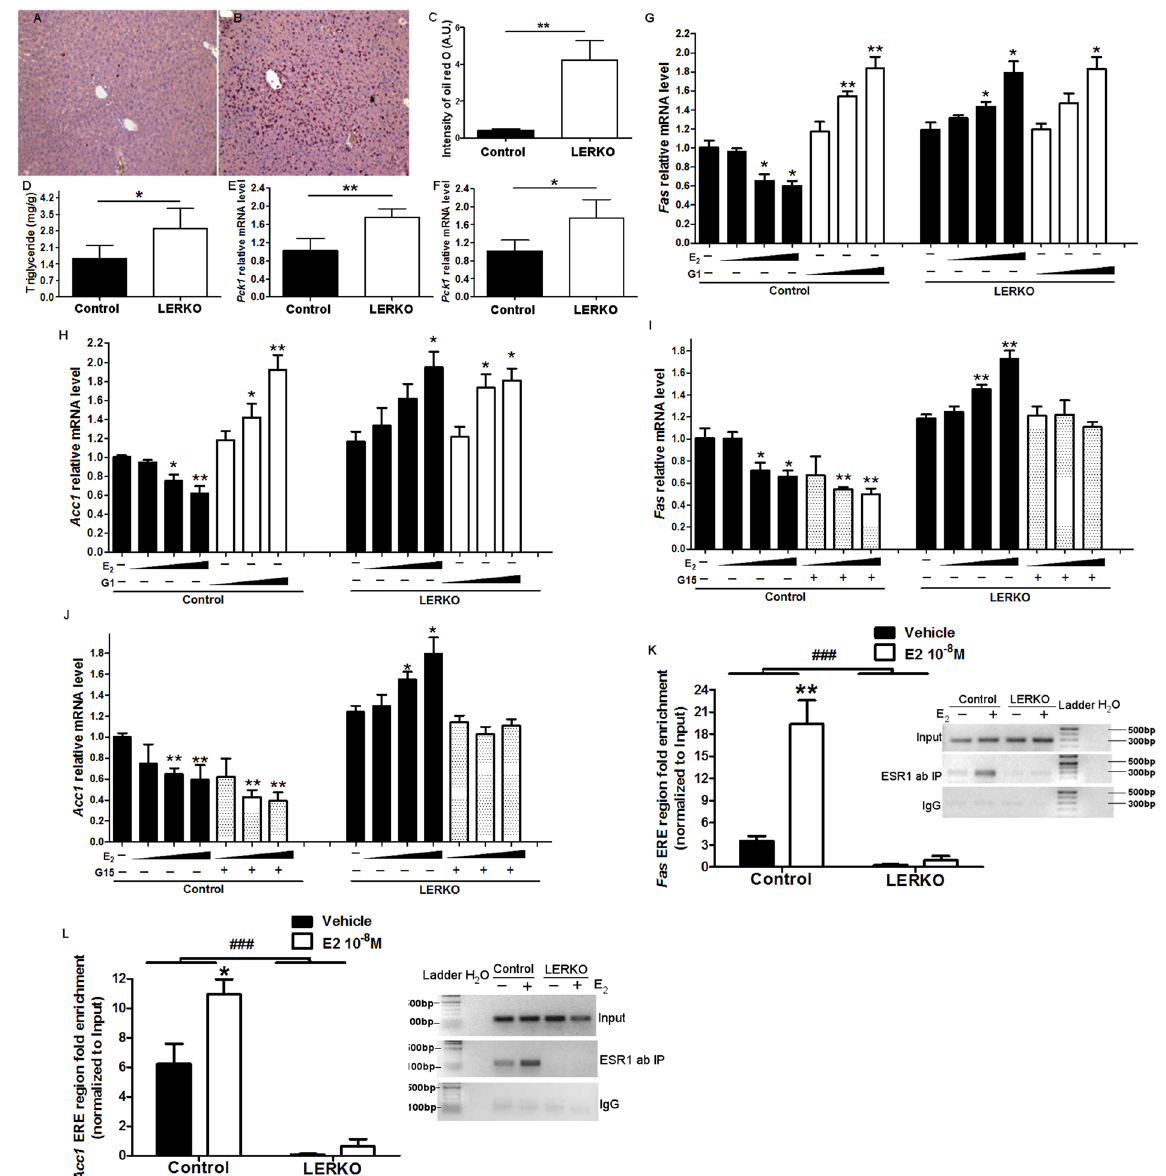
Figure 4. E 2 /ESR1 signaling inhibits hepatic lipogenesis. Representative images of liver sections from Control ( A ) and LERKO ( B ) mice after staining with Oil Red O as a measure of lipid accumulation (magnification: × 20). n = 3 per group. ( C ) Quantification of Oil Red O staining using Image ( J ). ( D ) Hepatic triglyceride levels in Control and LERKO mice. ( E , F ) mRNA levels of hepatic lipogenic genes Fas and Acc1 in Control and LERKO mice were measured by q-RT-PCR. ( C – F ) * p < 0.05 versus Control, ** p < 0.01 versus Control. Data from Fig. 4E,F are representative of results obtained from 6–10 mice in each group. ( G , H ). Primary hepatocytes from Control and LERKO mice were treated with vehicle or different doses of E 2 (10 − 10 M, 10 − 9 M, 10 − 8 M) or GPER agonist G-1 (10 − 10 M, 10 − 9 M, 10 − 8 M), mRNA levels of Fas and Acc1 were measured by q-RT-PCR. * p < 0.05 versus vehicle, ** p < 0.01 versus vehicle, *** p < 0.001 versus vehicle. ( I , J ) Primary hepatocytes from Control and LERKO mice were treated with vehicle or different doses of E 2 (10 − 10 M, 10 − 9 M, 10 − 8 M) in absence or in presence of GPER antagonist G-15 (10 − 8 M), mRNA levels of Fas and Acc1 were measured by q-RT-PCR. * p < 0.05 versus vehicle, ** p < 0.01 versus vehicle, *** p < 0.001 versus vehicle. ( K , L ) ChIP assay experiments were performed with liver tissues using antibody to ESR1, or with rabbit preimmune serum (IgG) and primers flanking the Fas ( K ) and Acc1 ( L ) promoters. Real-time PCR data with an inset of a 1.5% agarose gel as a representative example. Results were normalized to input and shown as fold enrichment IgG from 3 independent ChIP experiments. The experiments were performed 2 weeks after virus injection. Values are means ± SD. * p < 0.05 versus IgG, *** p < 0.001 versus